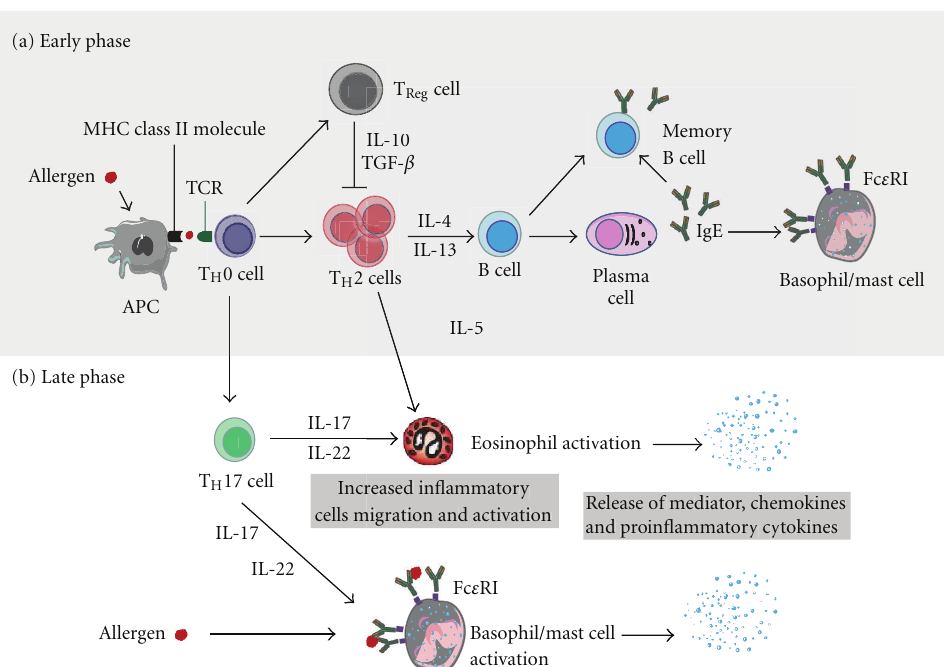
Figure 1: Mechanisms of allergic responses. Allergic response is constituted by two phases: an early phase (a) of initial sensitization and memory activation and a later phase response (b) after re-exposure to allergen, resulting in release of inflammatory mediators as a consequence of allergen cross-linking basophil/mast cell-bound specific